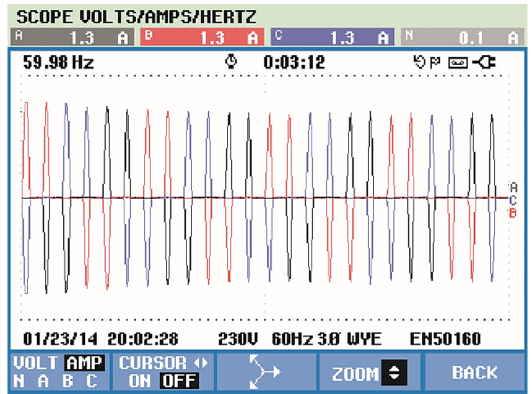
Figure 21. Source current with a nonlinear load (inverter + motor).